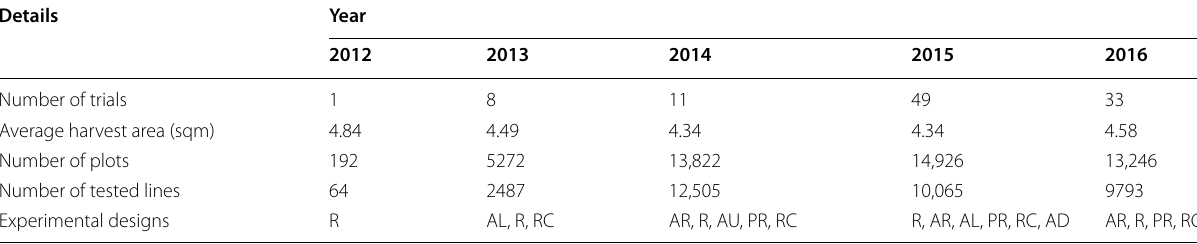
These trials were conducted during 2012–2016 for IRRI’s rice breeding program for irrigated systems Experimental design used in the retrieved studies included—R